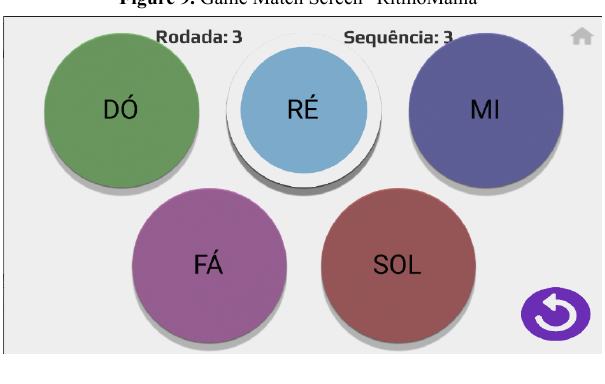
Figure 9. Game Match Screen “RitmoMania”